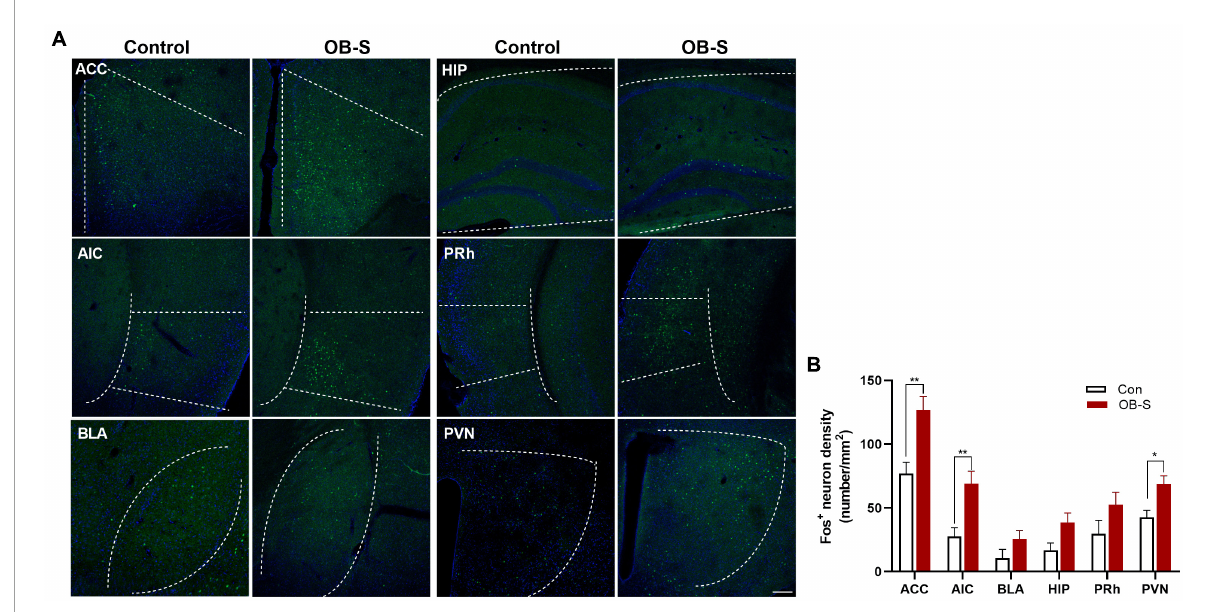
FIGURE8 Activation of neurons in different brain regions of susceptible mice. (A,B) Quantification of fos-like immunoreactivity in ACC, AIC, BLA, HIP, PRh, and PVN. ACC anterior cingulate cortex, AIC anterior insular cortex, BLA basolateral amygdale, HIP hippocampus, PRh perirhinal cortex, PVN paraventricular nucleus. n = 7 mice per group. Data are presented as means ± SEM. Sidask’s test analysis between each group as indicated * p < 0.05, ** p < 0.01. Scale bar, 100 µ